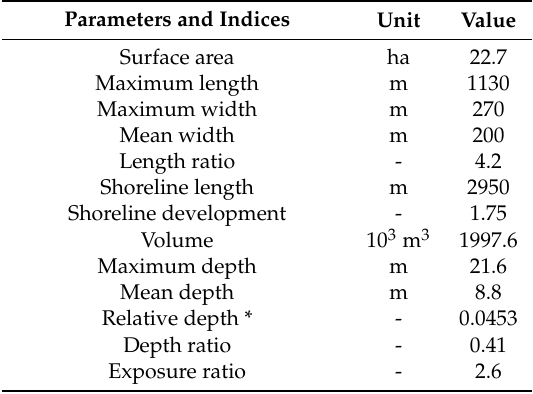
Table 1. Parameters and morphometric indices of Lubi´nskie Lake (according to Ja´nczak